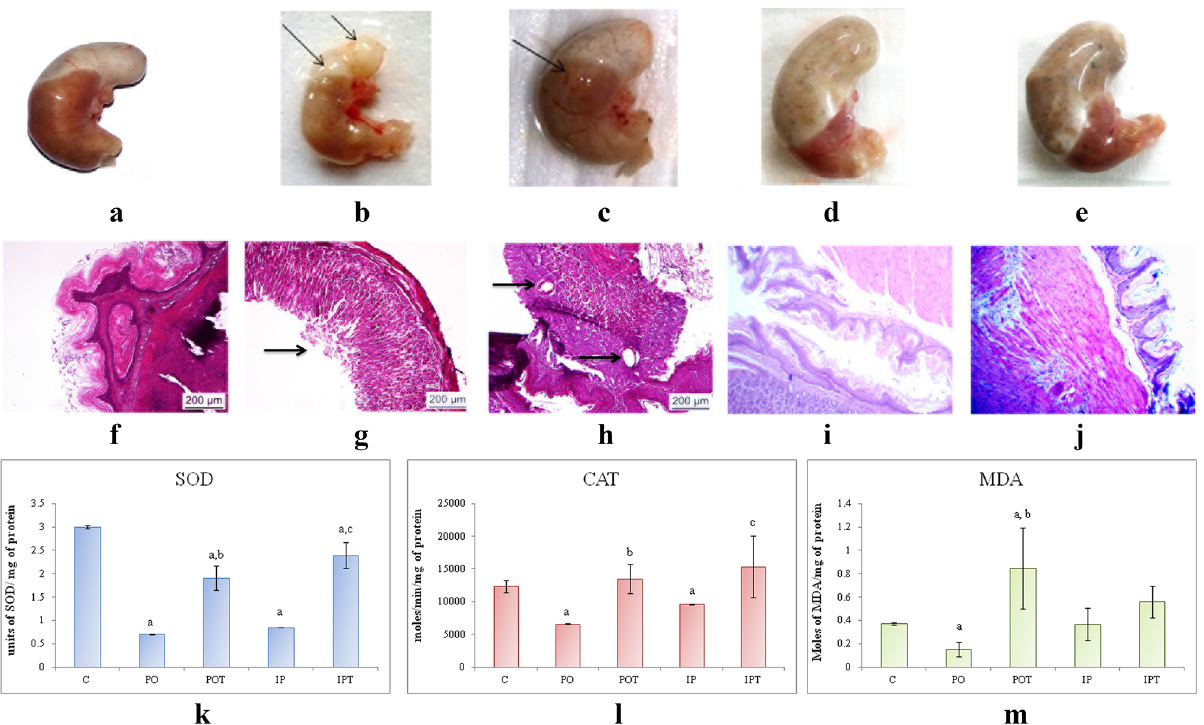
Figure 6. Stomach of ( a ) control, ( b ) PO group showing presence of multiple tumours as indicated by arrows, ( c ) IP group showing presence of tumour indicated by an arrow, ( d ) POT treatment showing normal stomach, ( e ) IPT group with no pathological changes. Photomicrographs of TS of stomach ( f ) control (HE, ×100) ( g ) PO-showing vacuolization (HE, ×100) ( h ) IP-showing ulcer (HE, ×100) ( i ) POT-showing normal architecture (HE, ×100) ( j ) IPT-showing normal architecture (HE, ×100). ( k ) Comparison of SOD activity in stomach of the control, experimental and treated animals. ( l ) Comparison of CAT activity in stomach of the